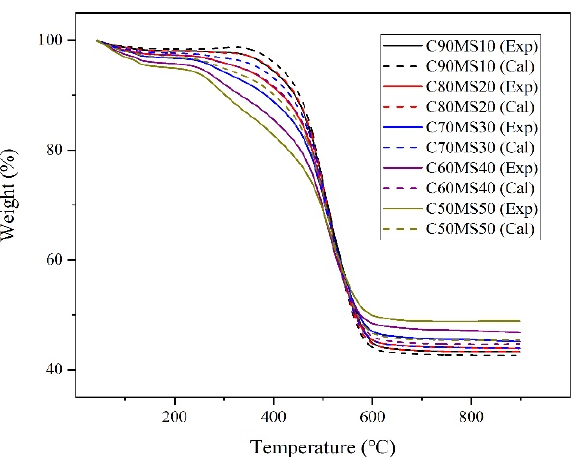
Figure 2. Comparison of experimental and calculated TG curves for five blend ratios of coal/municipal sludge blends at a heating rate of 10 °C/min. Exp, experimental curve; Cal, calculated curve.